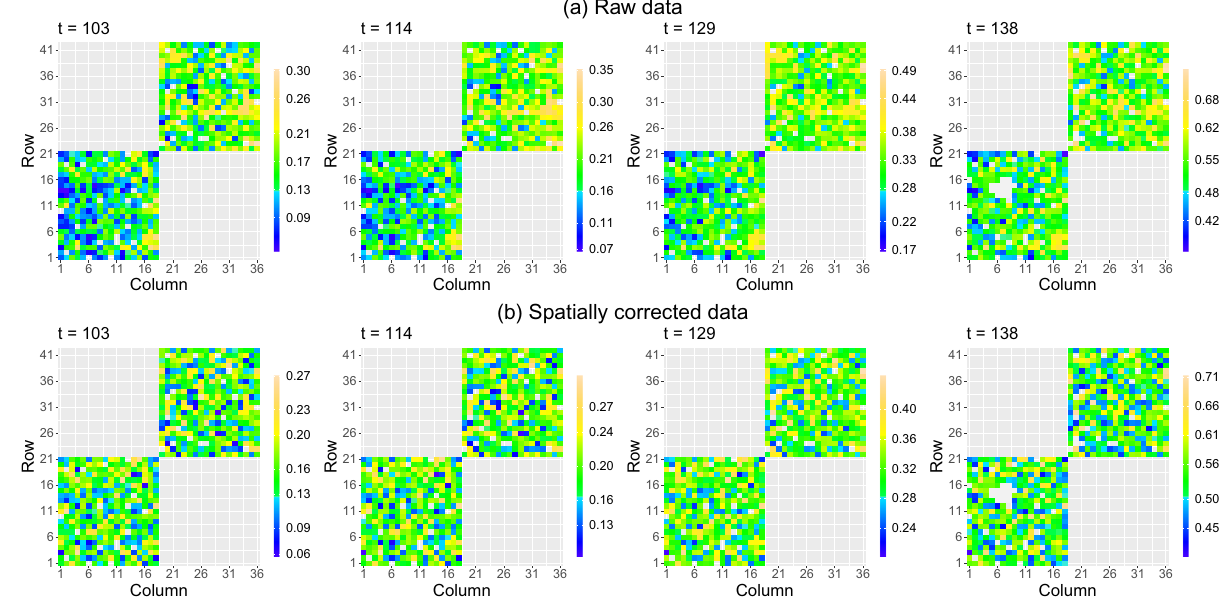
Figure 5. Results of the first stage of analysis for the ETH field phenotyping platform: Spatial distribution of the ( a ) raw and ( b ) spatially corrected canopy height at four different measurement days ( t = 103, 114, 129, 138 DOY). The white areas denote missing data. The colour scale is different for each